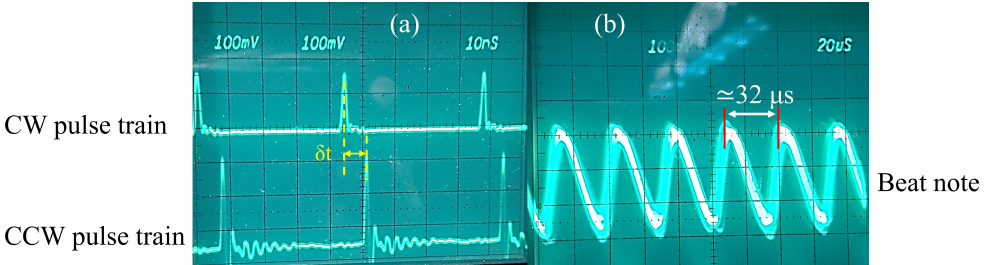
Figure 5. ( a ) Oscilloscope trace of the clockwise (upper) and counter-clockwise (lower) pulse trains in cross-polarized fiber laser. ( b ) The envelope of the modulated pulse train due to the asymmetry in the ring